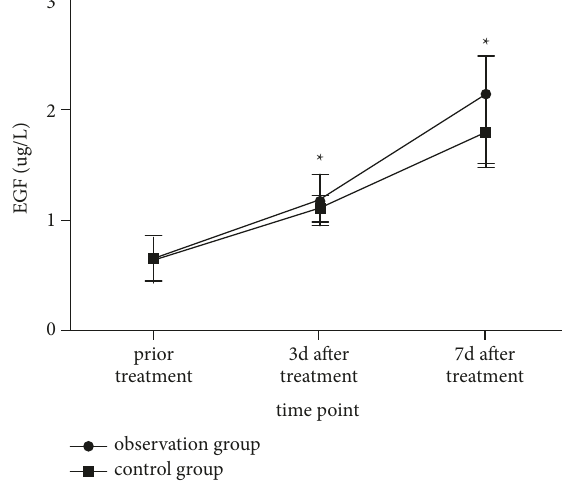
Figure 8: Comparison of EGR between the two groups before and after treatment.